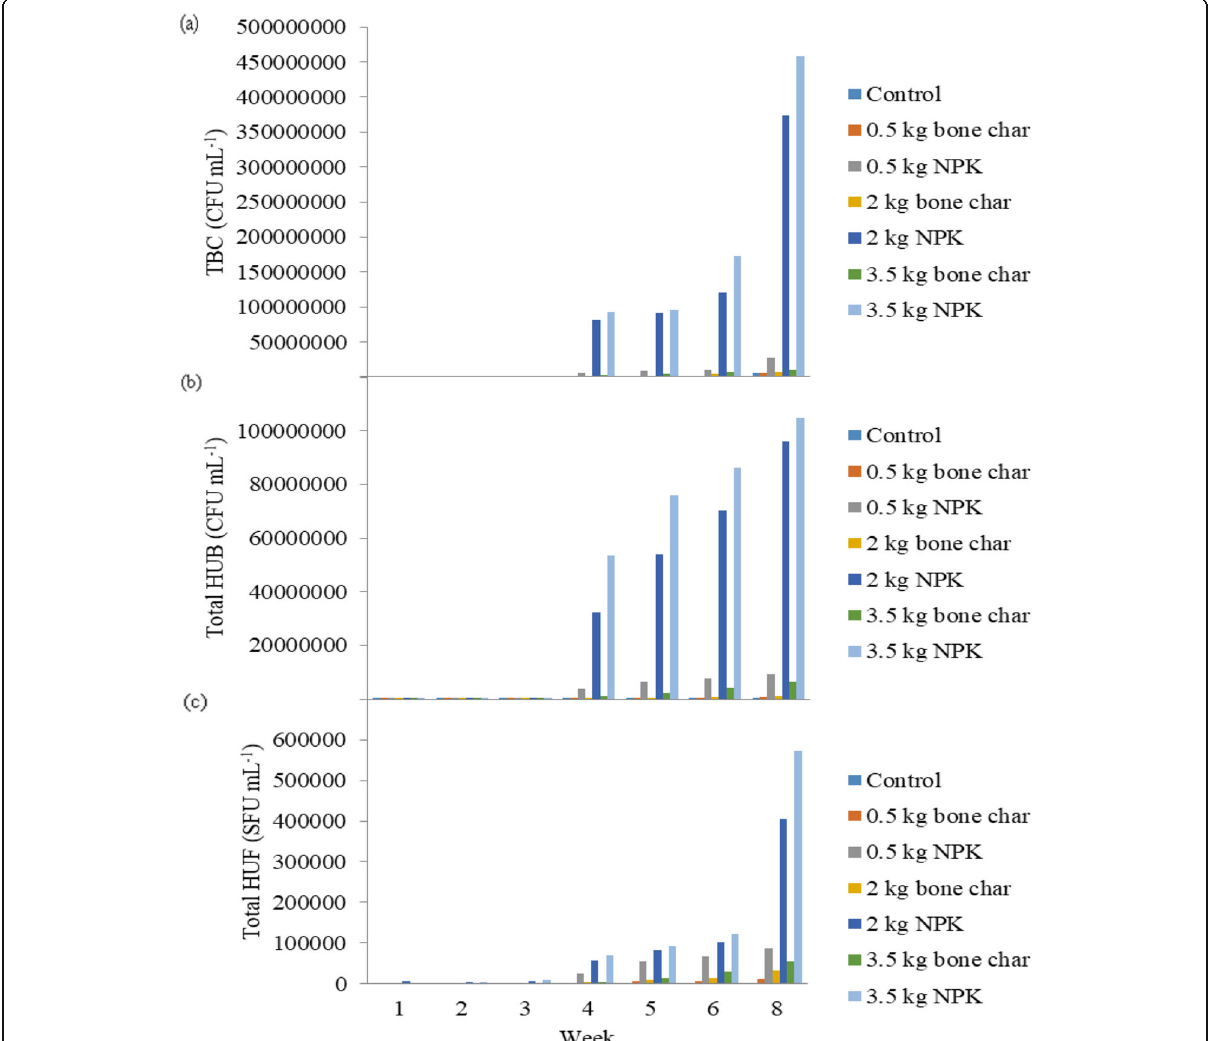
Fig. 4 Effect of treatment on ( a ) TBC ( b ) HUB ( c )